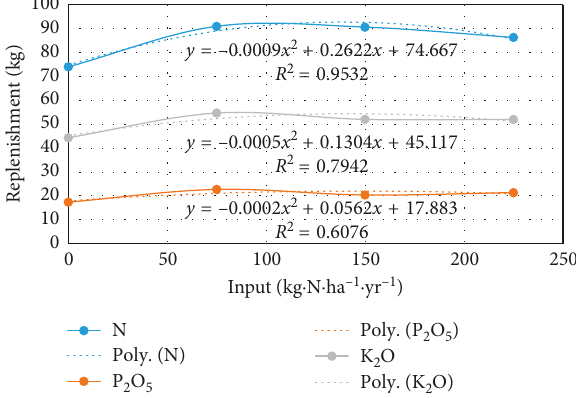
Figure 2: Soil nutrient replenishment model for